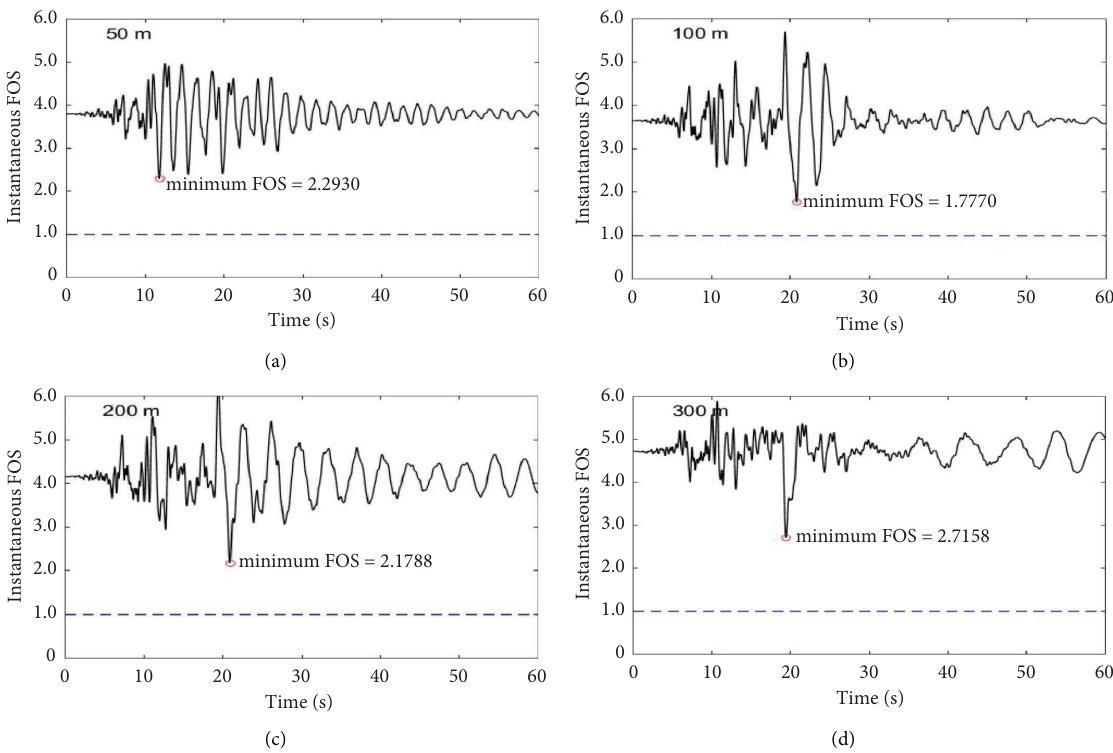
Figure 6: FOS time-history response of the open-pit slopes with diferent mining depths under the 2007 Chuetsu-oki earthquake record in Iizuna Imokawa station. (a) 50m. (b) 100m. (c) 200m. (d)